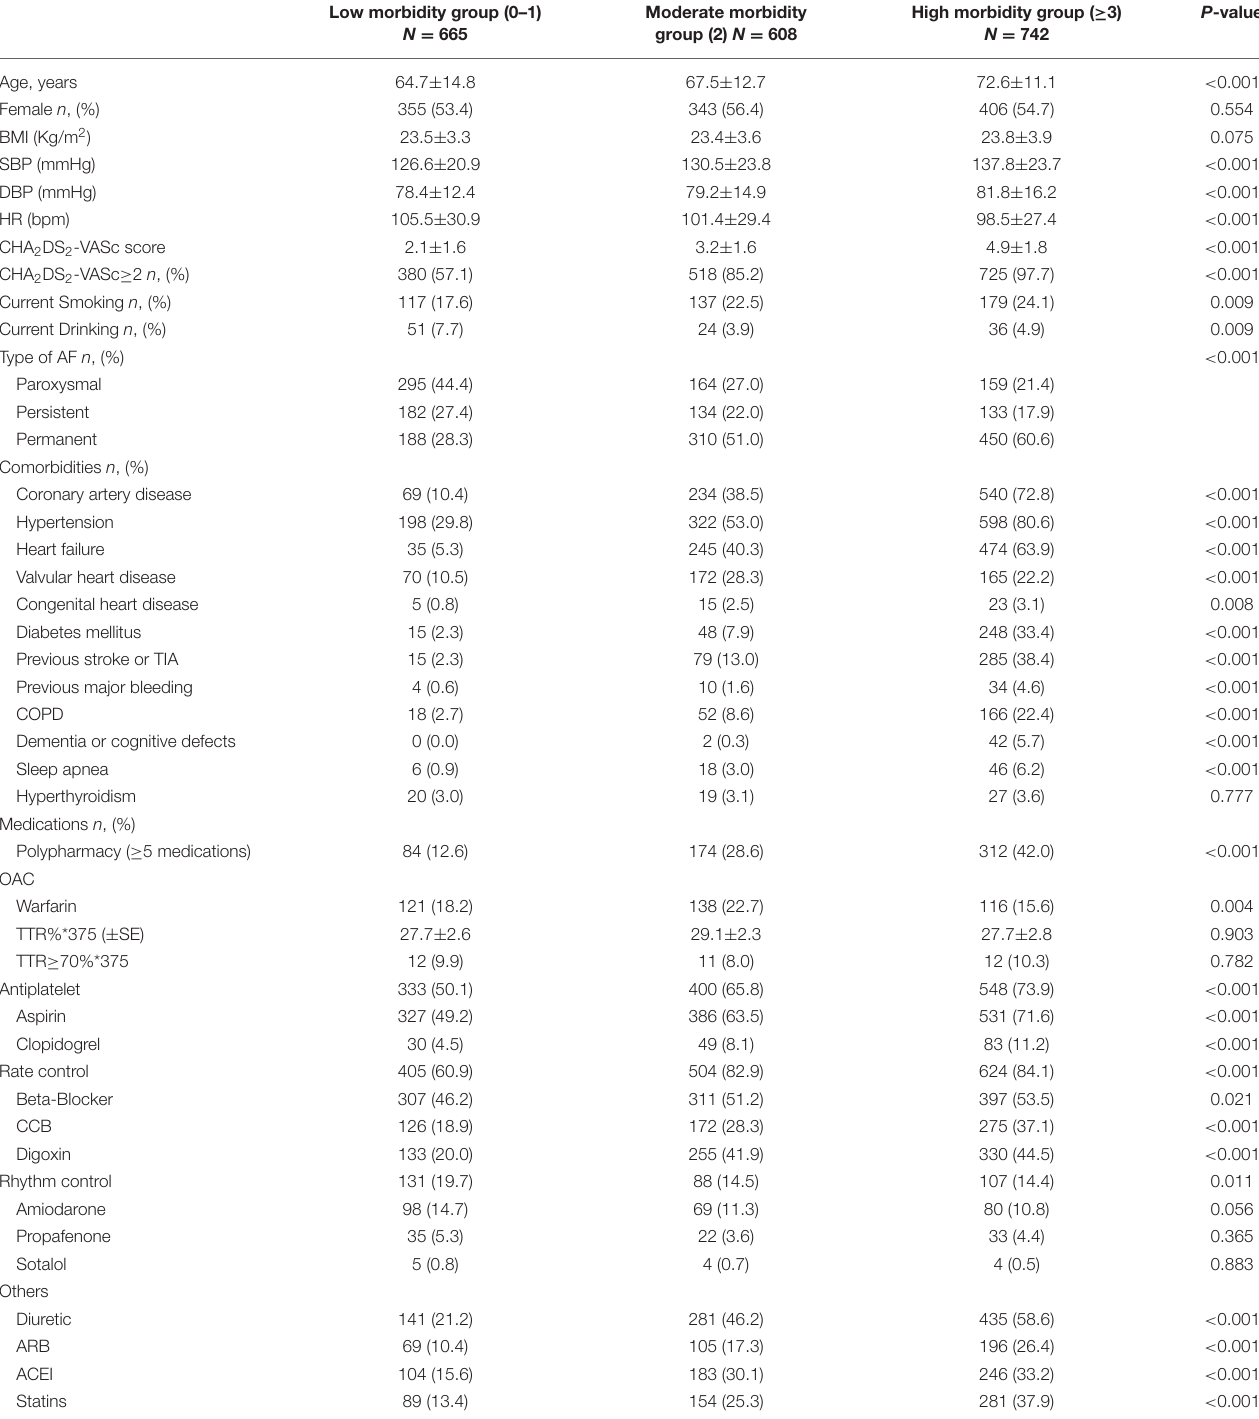
TABLE 1 | Baseline characteristic of AF patients by morbidity